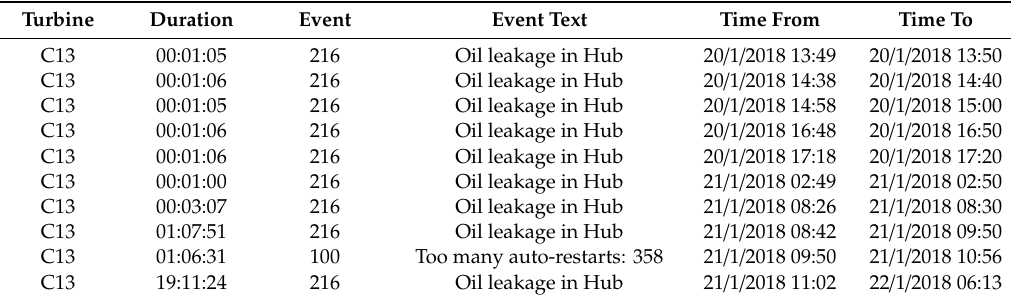
Table 2. Sample data: turbine